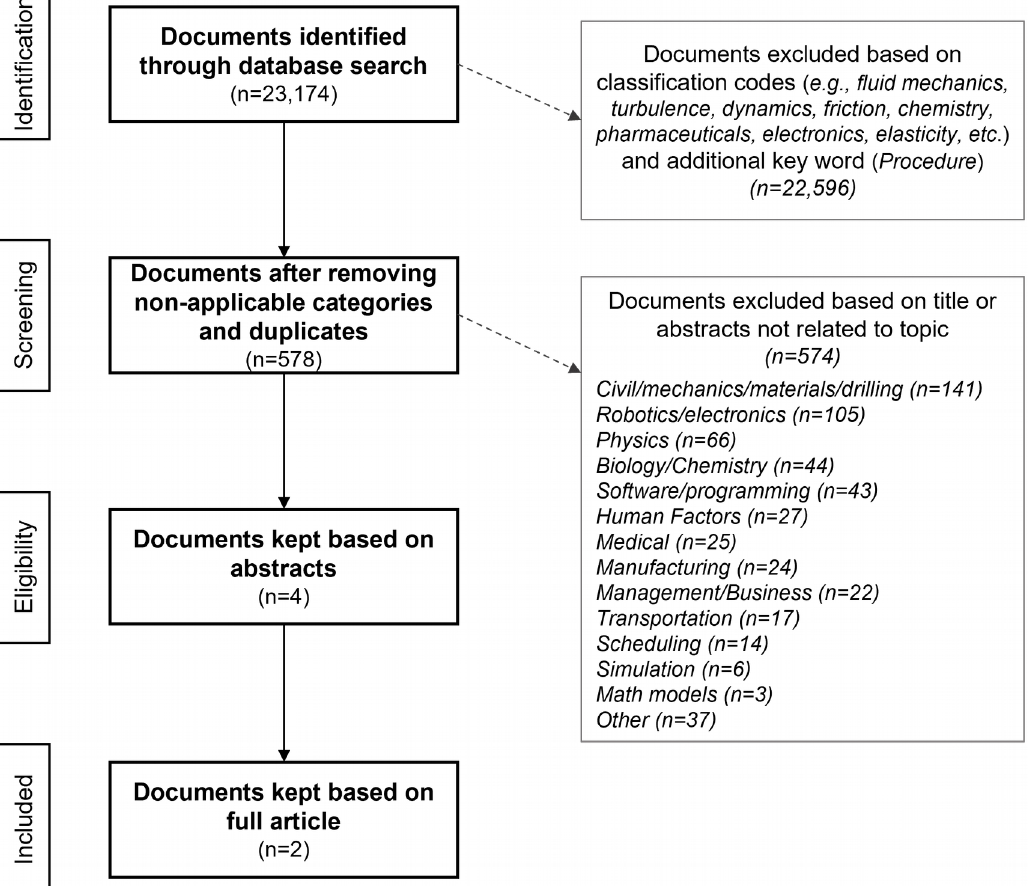
Figure 2. Agile Standardized Work Literature